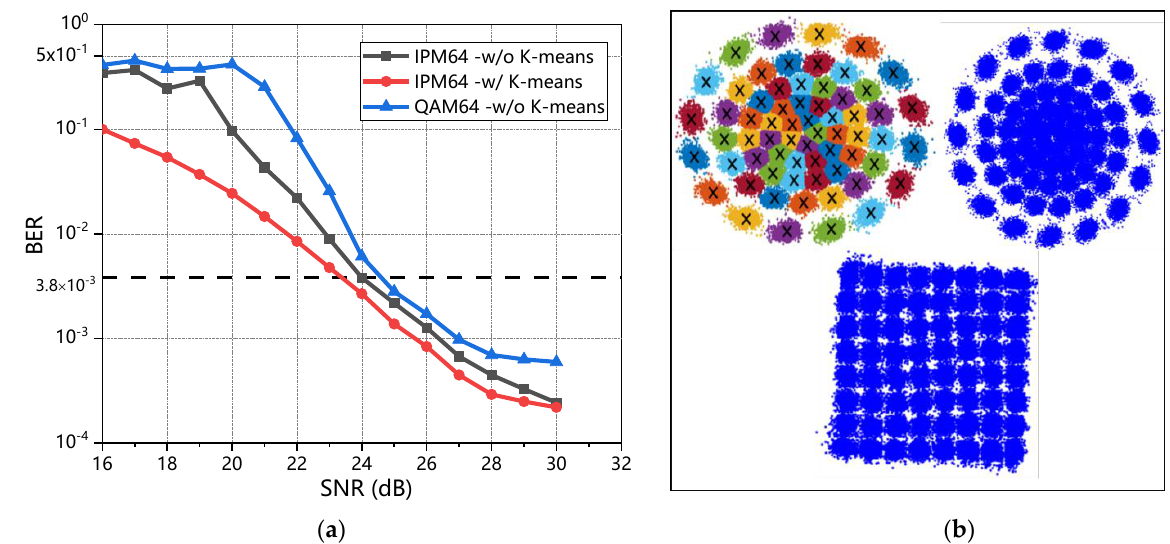
Figure 6. ( a ) BER versus SNR at loop = 5; ( b ) recovery constellation at SNR = 22dB; black intersections: ideal constellation points under impacting by NLPN (associated centroids); colored dots: the signals in the cluster associated with the nearest black intersections.